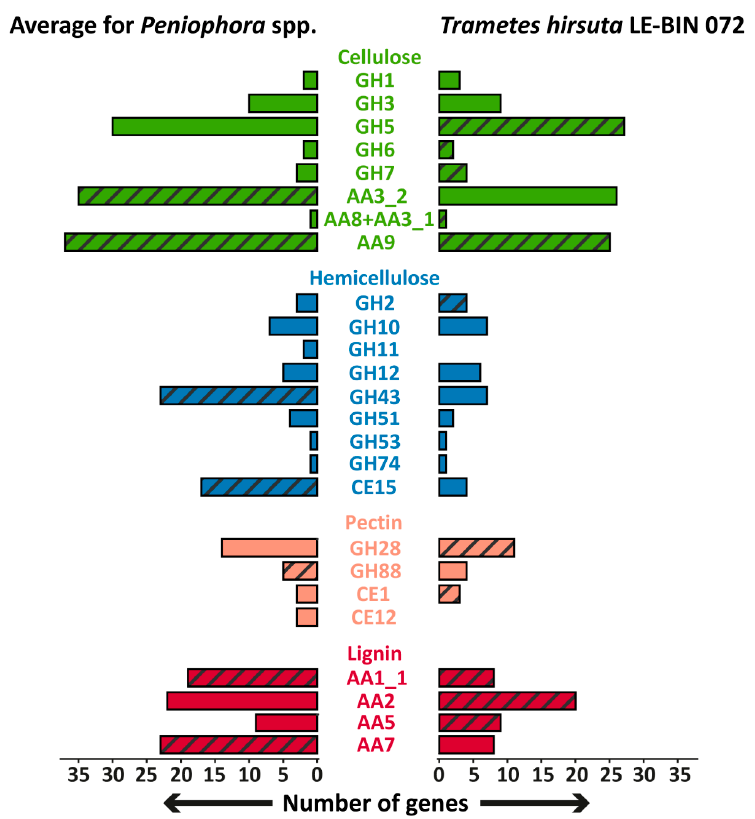
Figure 5. The comparison of the genome contents of Peniophora spp. and T. hirsuta LE-BIN 072. Groups of CAZymes that were detected in exoproteomes are hatched. The genes encoding CAZymes from GH26 and GH62 families were absent in the genomes of all fungi.